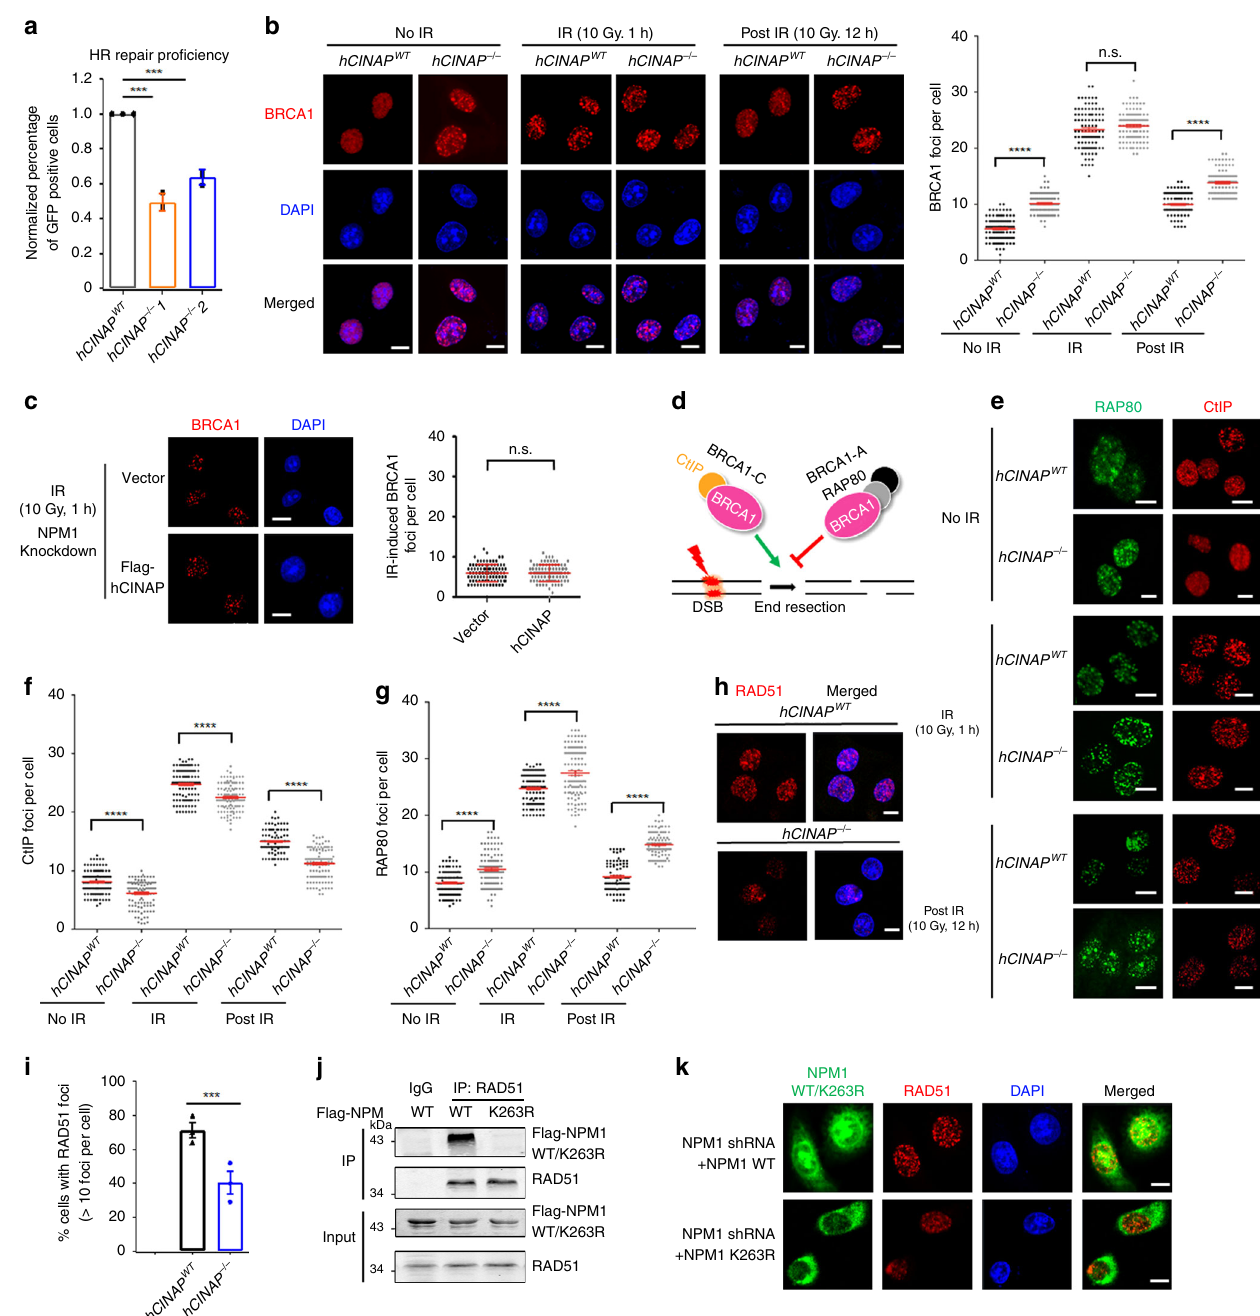
Fig. 5 Loss of hCINAP leads to a defect in error-free HR pathway. a hCINAP WT and hCINAP − / − HEK293T cells were subjected to HR assays. The data are presented as the mean ± SEM of three replicates. More than 1000 cells were counted in each group, two-tailed students ’ t test, *** P < 0.001. b hCINAP WT and hCINAP − / − U2OS cells treated with or without IR (10 Gy) were subjected to immuno fl uorescence assays. Representative immuno fl uorescence images are shown (left), and statistics of BRCA1 foci numbers in each group are shown (right). **** P < 0.0001. c NPM1 knockdown U2OS cells transfected with the indicated plasmids were treated with IR (10 Gy) and released for 1 h. The accumulation of BRCA1 was then assessed. Scale bar, 10 μ m. d Schematic of the role of different BRCA1 complex in end resection. e – g hCINAP WT and hCINAP − / − U2OS cells were immunostained with anti-RAP80 or anti-CtIP antibodies. Representative immuno fl uorescence images are shown in e , and BRCA1 foci numbers in cells were counted in f and g . Scale bar, 10 μ m. **** P < 0.0001. h , i Immuno fl uorescence h and its quanti fi cation i showing that hCINAP de fi ciency blocked the RAD51 foci recruitment. Representative images and percentages of cells with > 10 RAD51 foci were counted. The U2OS cells were treated with 4 Gy IR and released 4 h before fi xing. Scale bar, 10 μ m. *** P < 0.001. j HEK293T cells transfected with the indicated vectors were subjected to co-IP analysis using the indicated antibodies. k Cells were exposed to 10 Gy IR and then recovered for 1 h before being subjected to immuno fl uorescence. Scale bar, 10 μ m. Additional cell images and quanti fi cation of RAD51 foci are shown in Supplementary Fig. 12. For b , c , f , g , the results are shown as the mean ± SEM from three independent experiments. Data were analyzed using Student ’ s t test. More than 100 cells were counted per group. Unprocessed scans of blots are provided in Supplementary Fig.